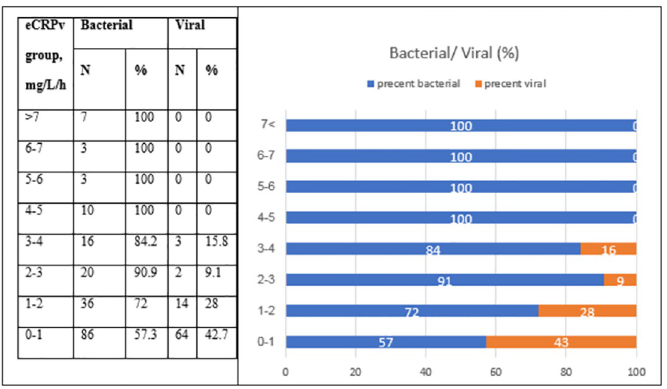
Fig 4. The ratio between bacterial (blue) and viral (orange color) infections in each range of eCRPv values.